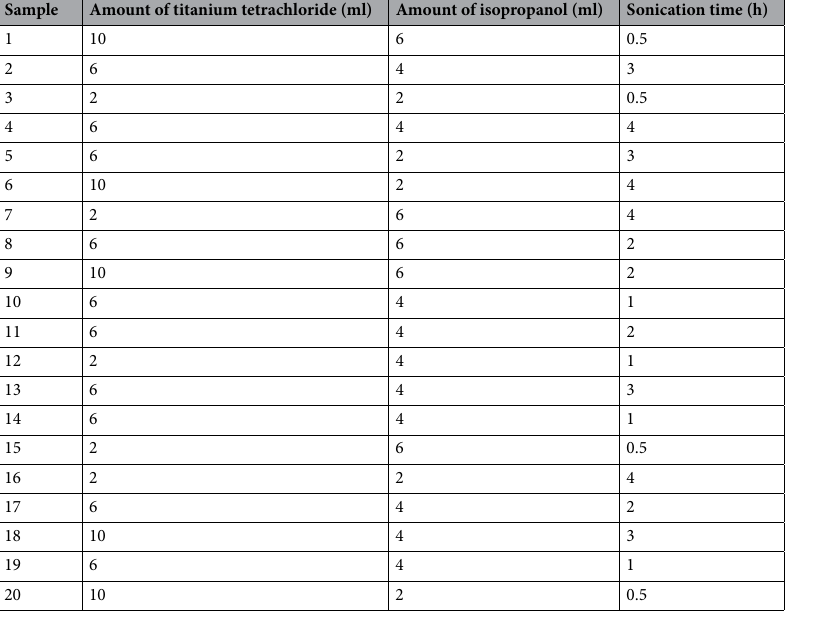
Table 1. The input variables and experimental